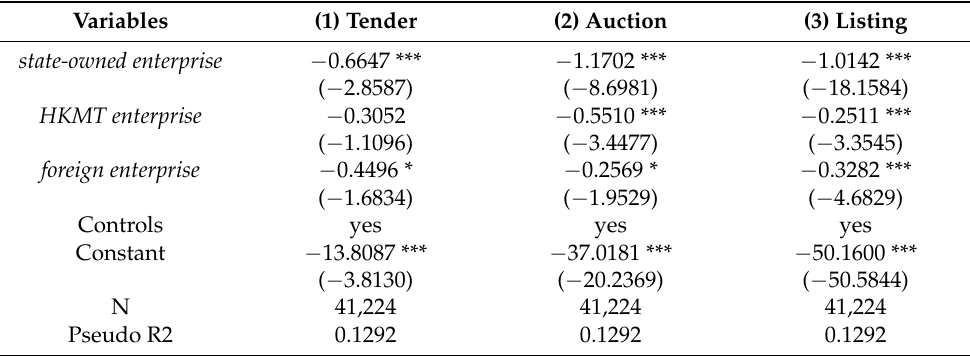
Table A4. Results of mlogit model considering types of enterprises (2007–2013).